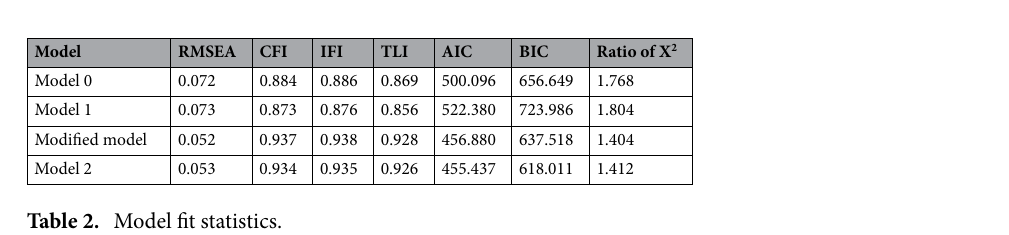
Table 2. Model fit